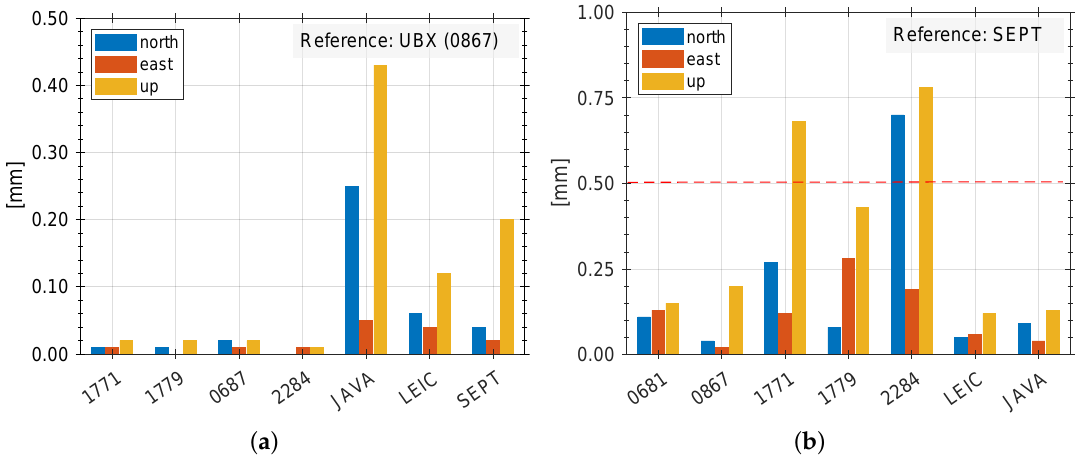
Figure 13. Position solution obtained from seven daily batches on a short baseline, with reference SEPT ( a ) and NEO-M8T 0867 ( b ). The dashed line in Figure 13a indicates half of the level of repeatability of Figure 13b.